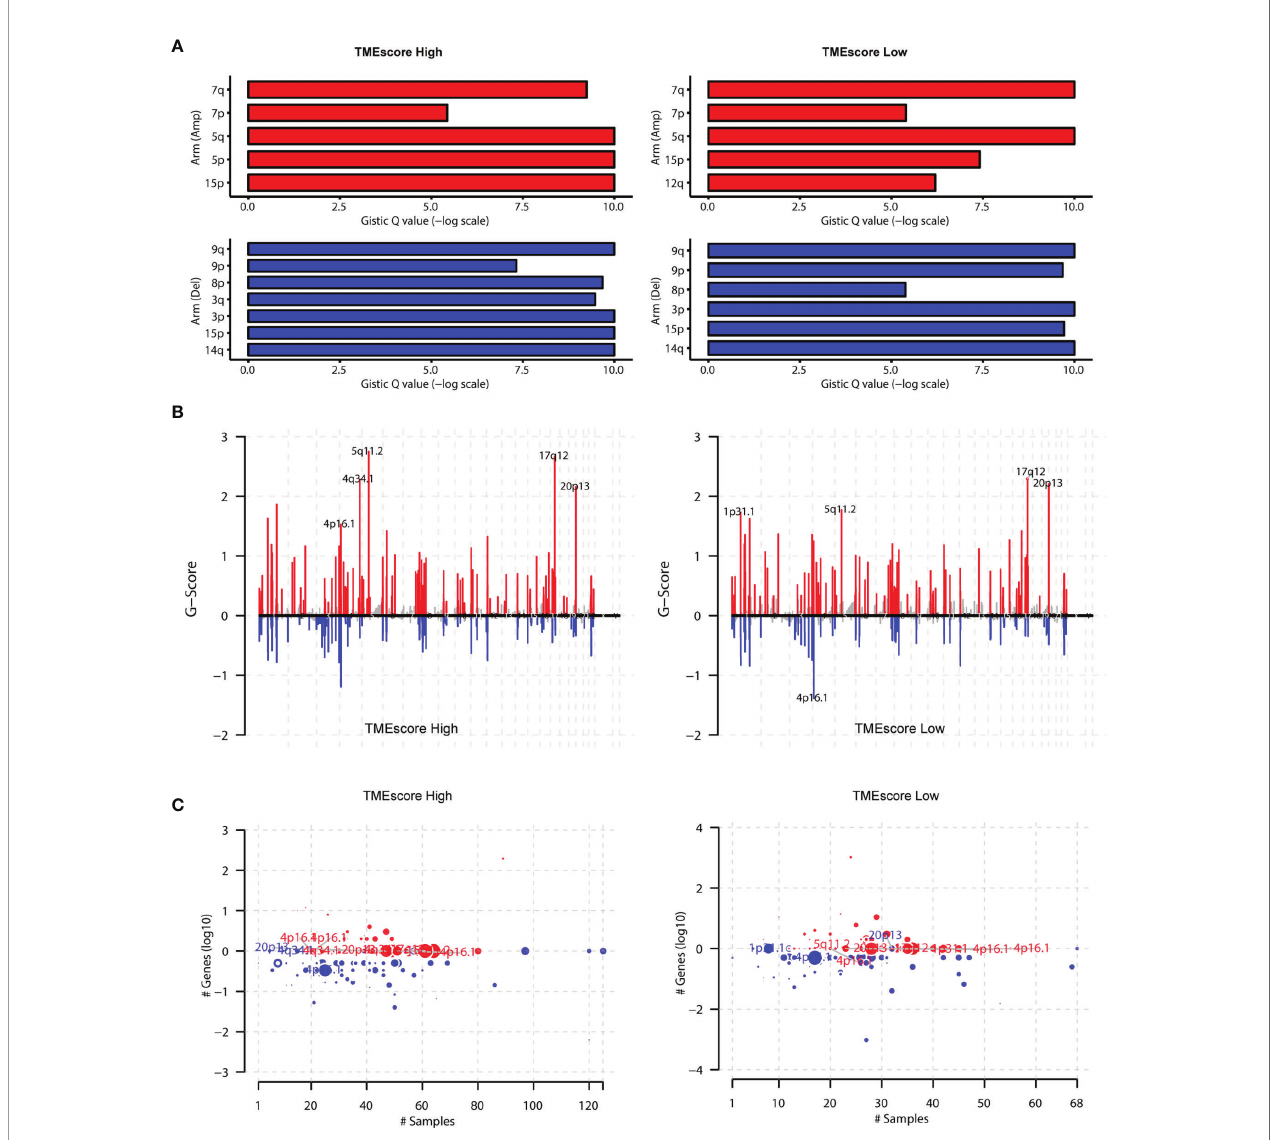
FIGURE 6 | Assessment of copy number variation (CNV) burden in two TMEscore groups. (A) We also conducted the GISTIC software to analyse the copy number variations in two groups and found that the ampli fi cation of 15p, 5q, 5p and deletions of 9q, 15p, 14q were the most prominent in TME-high group. However, the ampli fi cation of 7q, 5q and the deletions of 9q, 3p, 14q were the most signi fi cant in the TME-low group. (B) Besides, we totally detected 102 ampli fi cations TME- high samples (MCRs, q-value<1e-4), among which 5q11.2, 17q12, and 4q34.1 were the most signi fi cantly ampli fi ed regions. In TME-low samples, we totally detected 87 ampli fi cations and found 17q12, 20p13, 5q11.2 were the most signi fi cantly ampli fi ed regions. (C) The 79 copy number deletions in TME-high samples were detected, among which 4p16.1, 3q29, and 1q21.3 were the most signi fi cantly deleted regions. However, 1q21.3, 12p13.31 were the most signi fi cantly deleted regions in TMEscore low